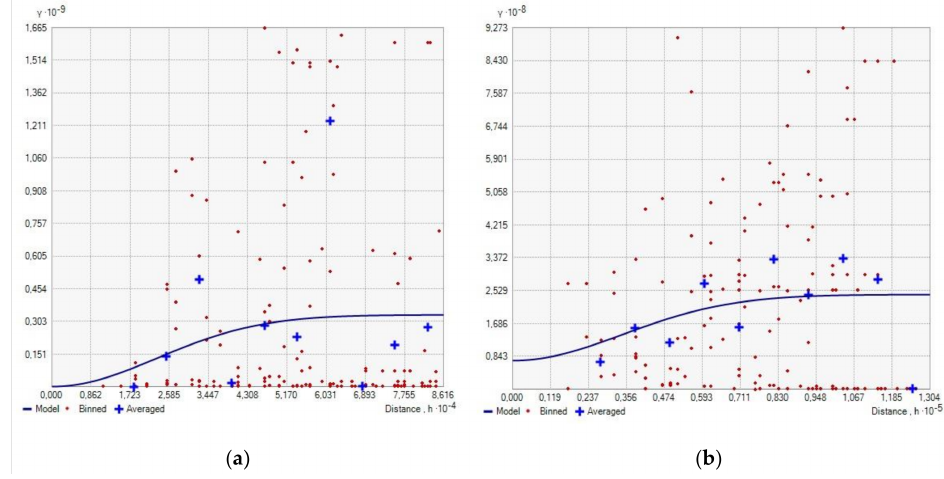
Figure 4. Semivariogram illustrating the relationship between the number of participants and the distance from urban agglomerations of Warsaw ( a ) and Tricity ( b